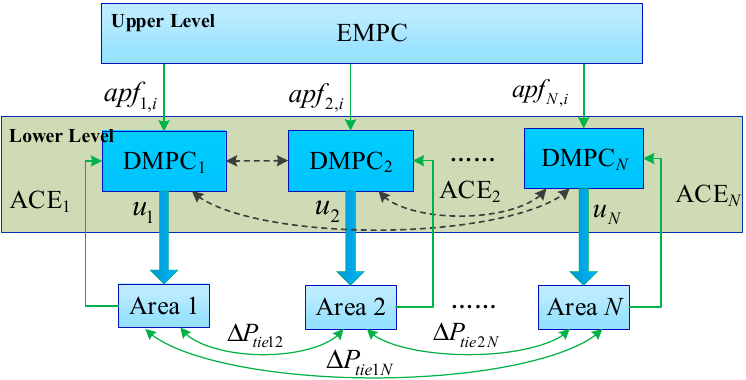
Figure 3. Bi-level model predictive control framework. EMPC, upper-level economic model predictive control; DMPC, distributed model predictive control.